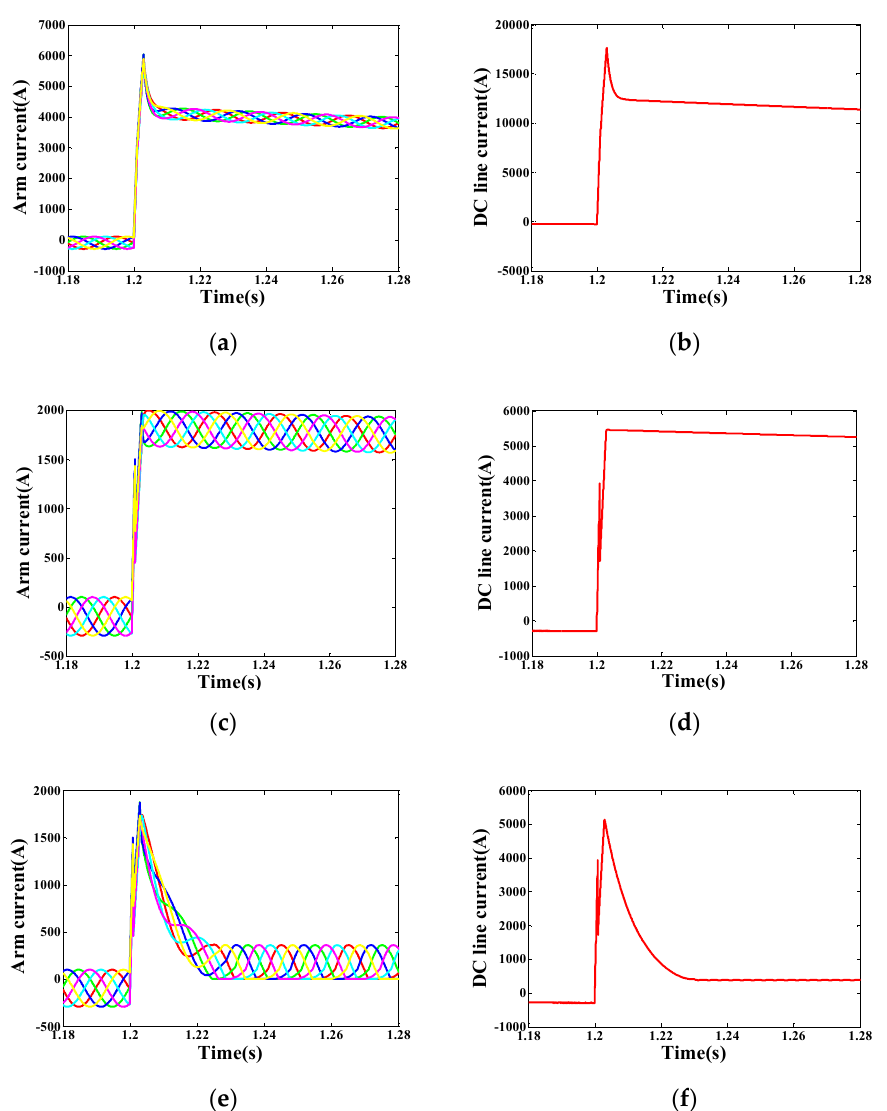
Figure 19. FCL ability comparison among existing methods: ( a ) Arm current in the resistance-based method, ( b ) DC line current in the resistance-based, ( c ) Arm current in the inductance-based method, ( d ) DC line current in the inductance-based method, ( e ) Arm current in the proposed method, ( f ) DC line current in the proposed method.